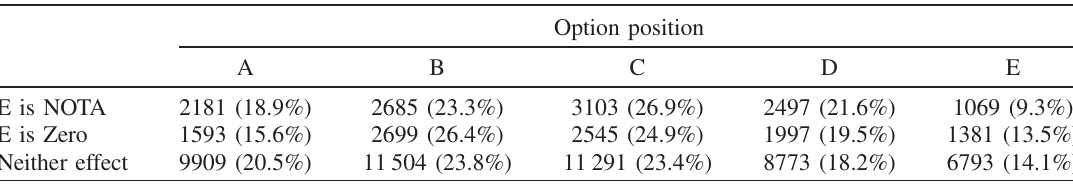
TABLE V. Total number of students selecting each distractor for five-option multiple-choice questions in data set 2 under three conditions (E was a NOTA option, E was a zero option, or neither NOTA nor zero options were present). For each condition equal numbers of incorrectly answered questions were sampled with options A, B, C, D, and E as the correct answer. All distributions of distractor selection were significantly different from a random distribution based on a χ 2 test ( p < 0 . 001 ).